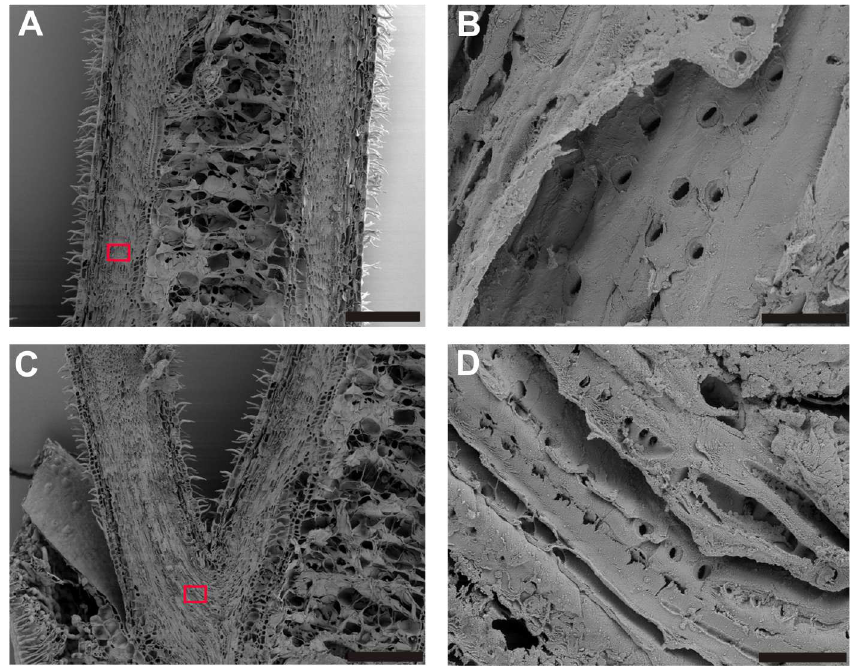
Fig 5. SEM Imagesof a longitudinalsectionof the vegetative shoot(A, B) and the ice barrierzone (C, D) in C . vulgaris . Magnifications of the areasindicatedby red rectangles (A, C) are shown on the right(B, D). In A and C: black bar = 200 μ m, in B and D: black bar = 8 μ